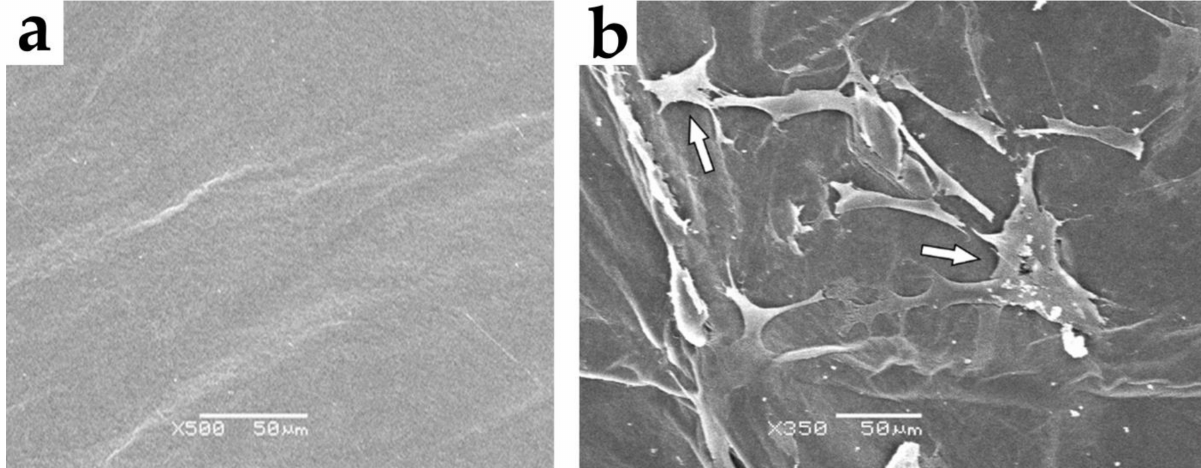
Figure 4. ( a ). SEM analysis showing bacterial cellulose (BC) membrane without cells. Images 500 × , scale bar = 50 µ m. ( b ). SEM analysis of the BC membrane containing cocultured skeletal muscle cells and bone marrow mesenchymal stem cells (for 14 days). Arrows indicate cell adhesion. Images 350 × , scale bar = 50 µ